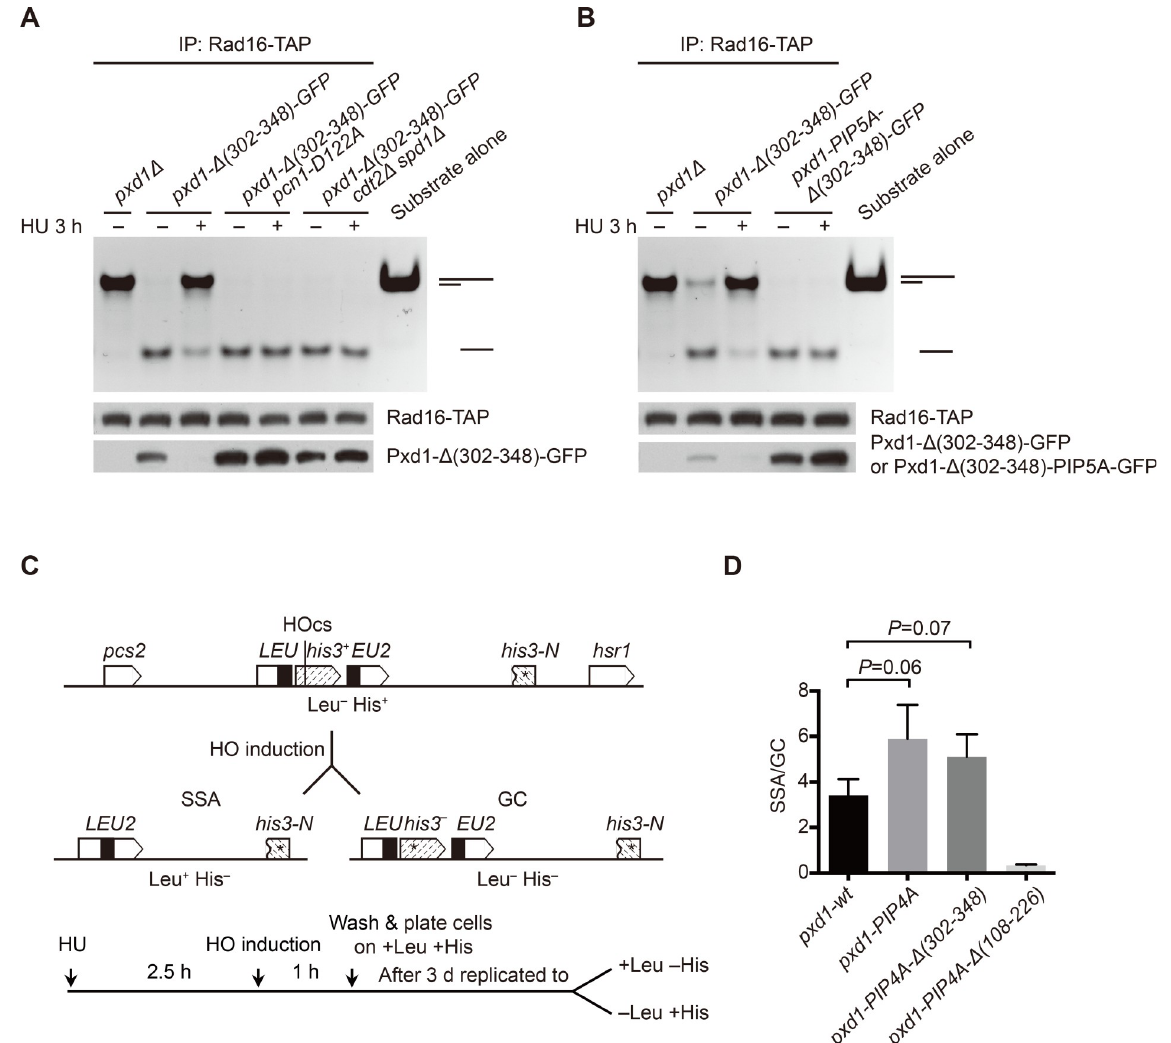
Fig 6. CRL4 Cdt2 -mediated degradation of Pxd1 reduces Rad16 nuclease activity and restrains SSA in S phase. (A) The nuclease activity of Rad16 was reduced in HU-arrested S-phase cells and this reduction was blocked in pcn1-D122A and cdt2 Δ spd1 Δ mutants. Rad16-TAP was immunoprecipitated with IgG beads from indicated strains expressing Pxd1- Δ (302–348), and then incubated with a 3 0 overhang DNA substrate for 1 h at 30˚C. After separation by a 10% native PAGE gel, the reaction products were stained by ethidium bromide. (B) pxd1-PIP5A